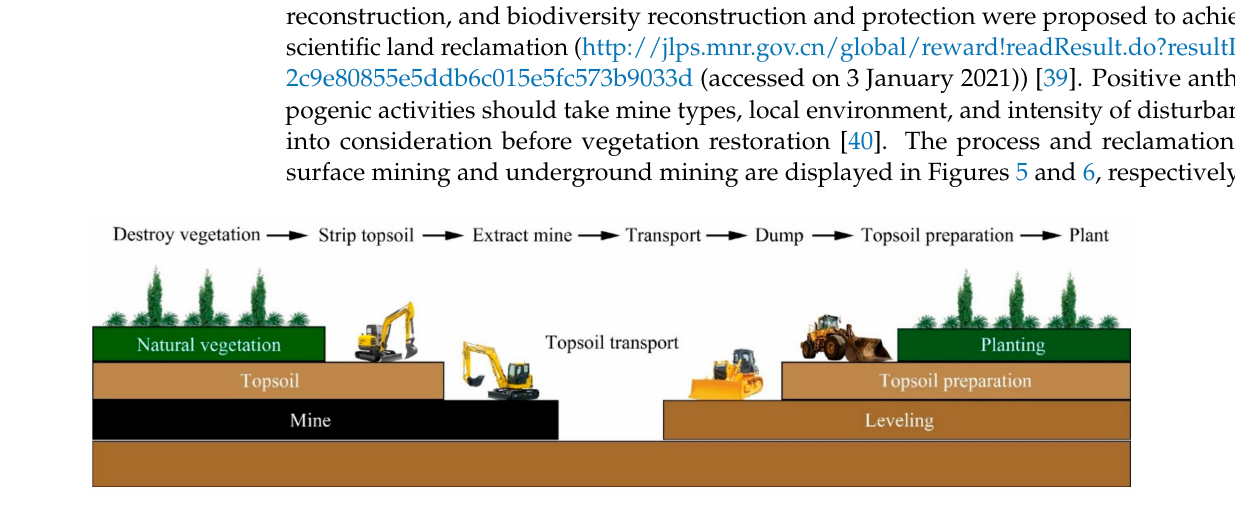
Figure 5. The process and reclamation of surface mining [39].